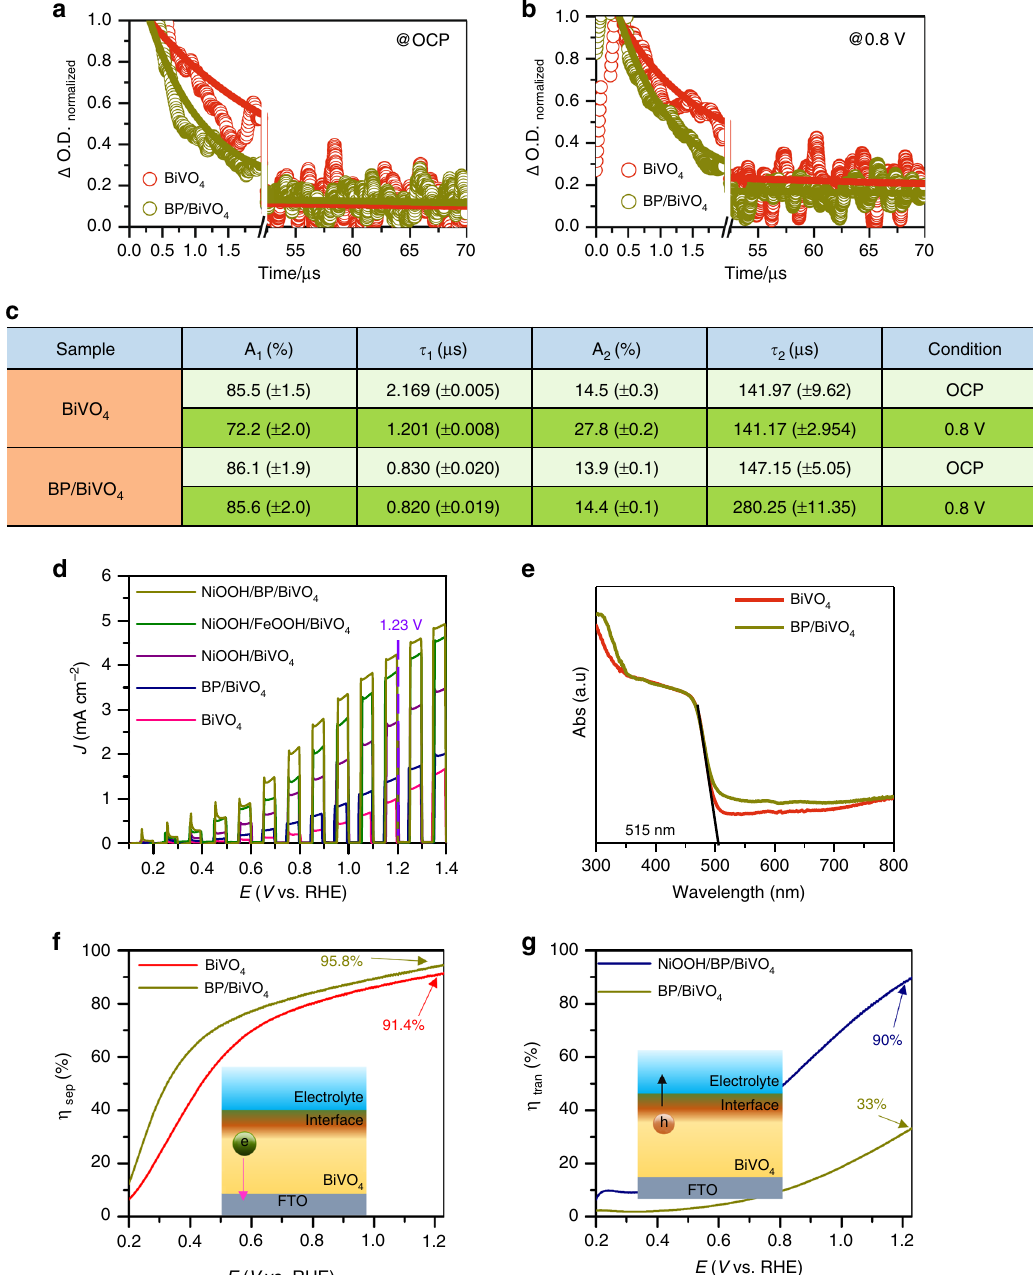
Fig. 3 In-situ TA spectroscopic evidence for hole extraction as a function of applied bias. The decay recorded at 500 nm under OCP and 0.8 V vs Ag/AgCl in 0.5 M KPi electrolyte (pH = 7.1) was fi tted to a biexponential decay model, y ¼ y 0 þ A 1 e (cid:2)ð x (cid:2) x 0 Þ = t 1 þ A 2 e (cid:2)ð x (cid:2) x 0 Þ = t 2 for ( a ) BiVO 4 and ( b ) BP/BiVO 4 . c Fitting parameters of the TA signals. PEC performance, optical properties and electrochemical characterizations. d Chopped J – V curves of various photoanodes in KPi electrolyte (pH = 7.1) under AM 1.5 illumination. e UV – Vis absorbance of BiVO 4 and BP/BiVO 4 photoanodes. f Charge